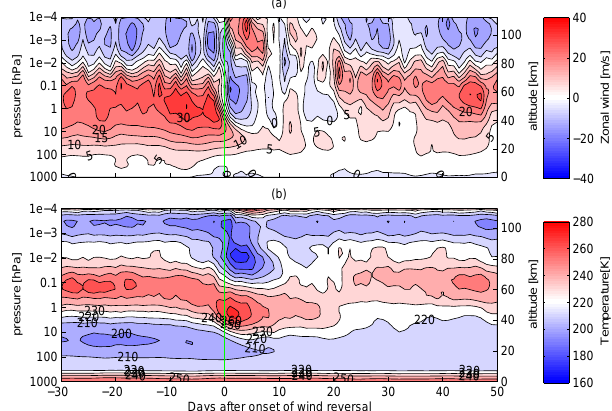
Figure 2. Composite (based on seven SSW ES events) of polar cap (70–90 ◦ ) zonal-mean zonal wind (a) and temperature (b) observed by SD-WACCM. Day zero (vertical green line) marks the onset of the polar cap zonal-mean zonal wind reversal at 0.7hPa ( ∼